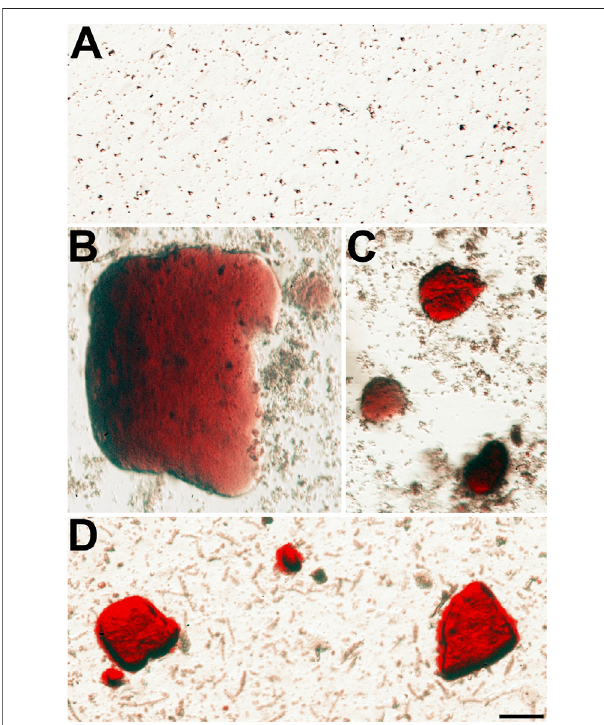
FIGURE 3 | Alizarin red-stained crystals are present in the insoluble fraction of homozygous Cx46fs380 lenses. (A) Image shows the absence of Alizarinred-stainedmaterialinthelensinsolublefractionofa191-day-oldwild- type Cx46fs380 male mouse. (B − D) Images show the presence of Alizarin red-stained crystals of different sizes in the lens insoluble fraction of a homozygous Cx46fs380 female littermate. The images were modi fi ed to decrease the reddish background from the Alizarin red solution in which the insoluble fraction was resuspended. The scale bar represents 54 µm.